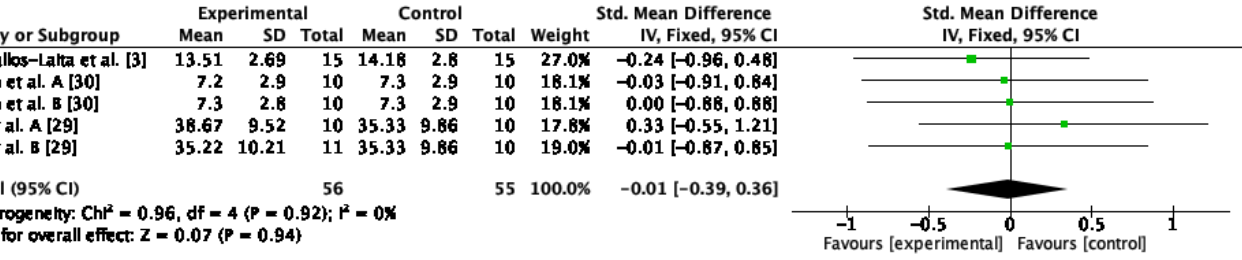
Figure 6. Forest plot of internal rotation strength for conservative therapy versus control/sham. Lluch et al. A. compared manual therapy versus control intervention. Lluch et al. B included the manual contact versus control intervention. Lo et al. A compared KT versus control intervention. Lo et al. B compared stretching versus control intervention.